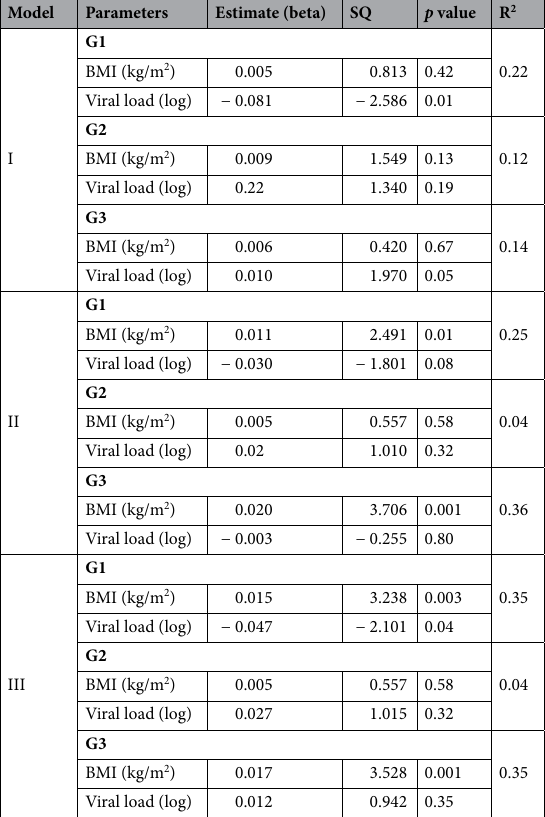
Table 6. Multiple linear regression models by groups for the lumbar spine (model I), femoral neck (model II) and total hip (model III) of patients with chronic hepatitis B virus infection using or not antiretroviral